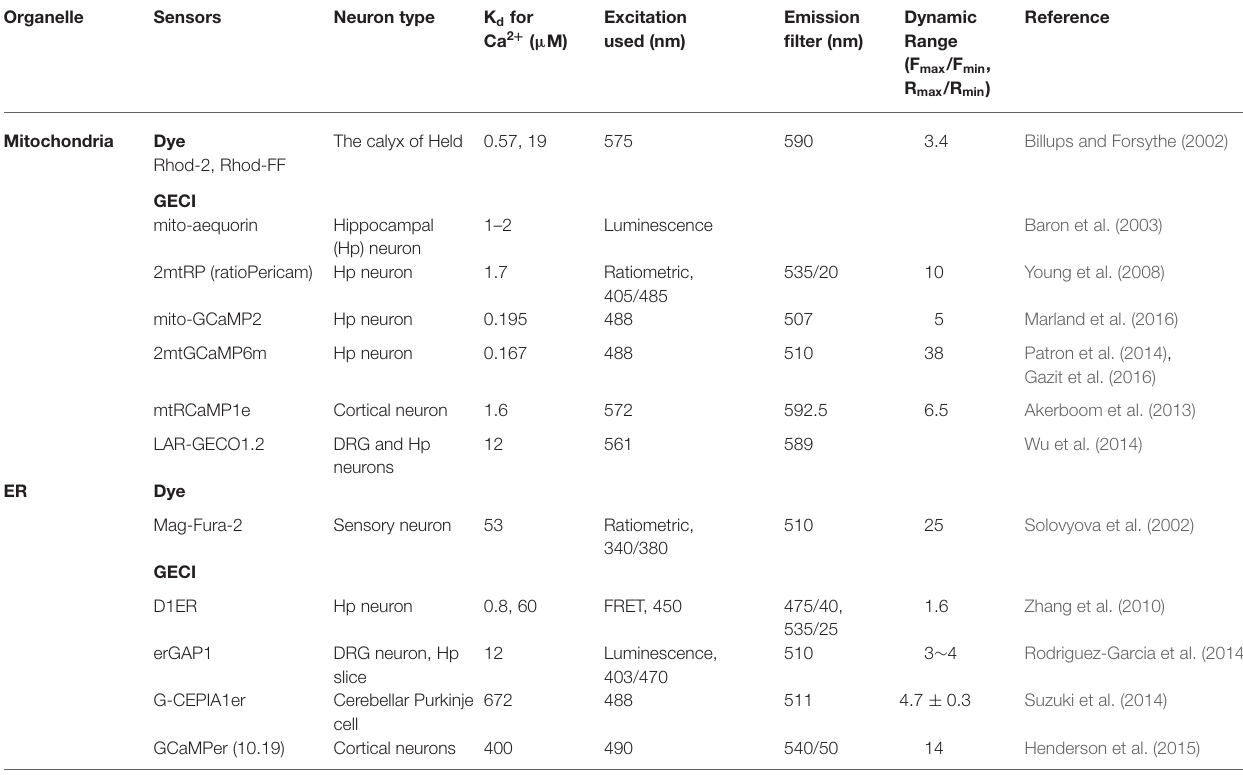
TABLE 1 | Organelle-specific Ca 2+ sensors in